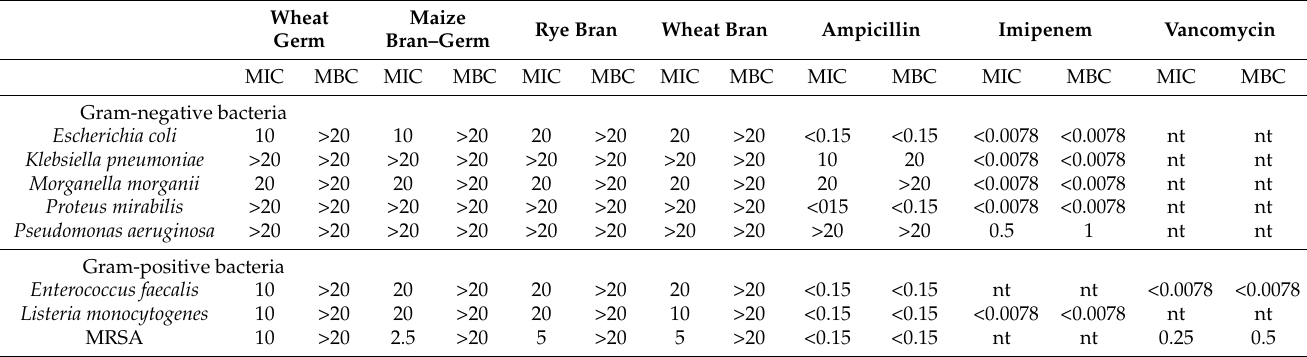
Table 7. Antibacterial activity (mg/mL) of the cereal by-product hydroethanolic extracts. Wheat